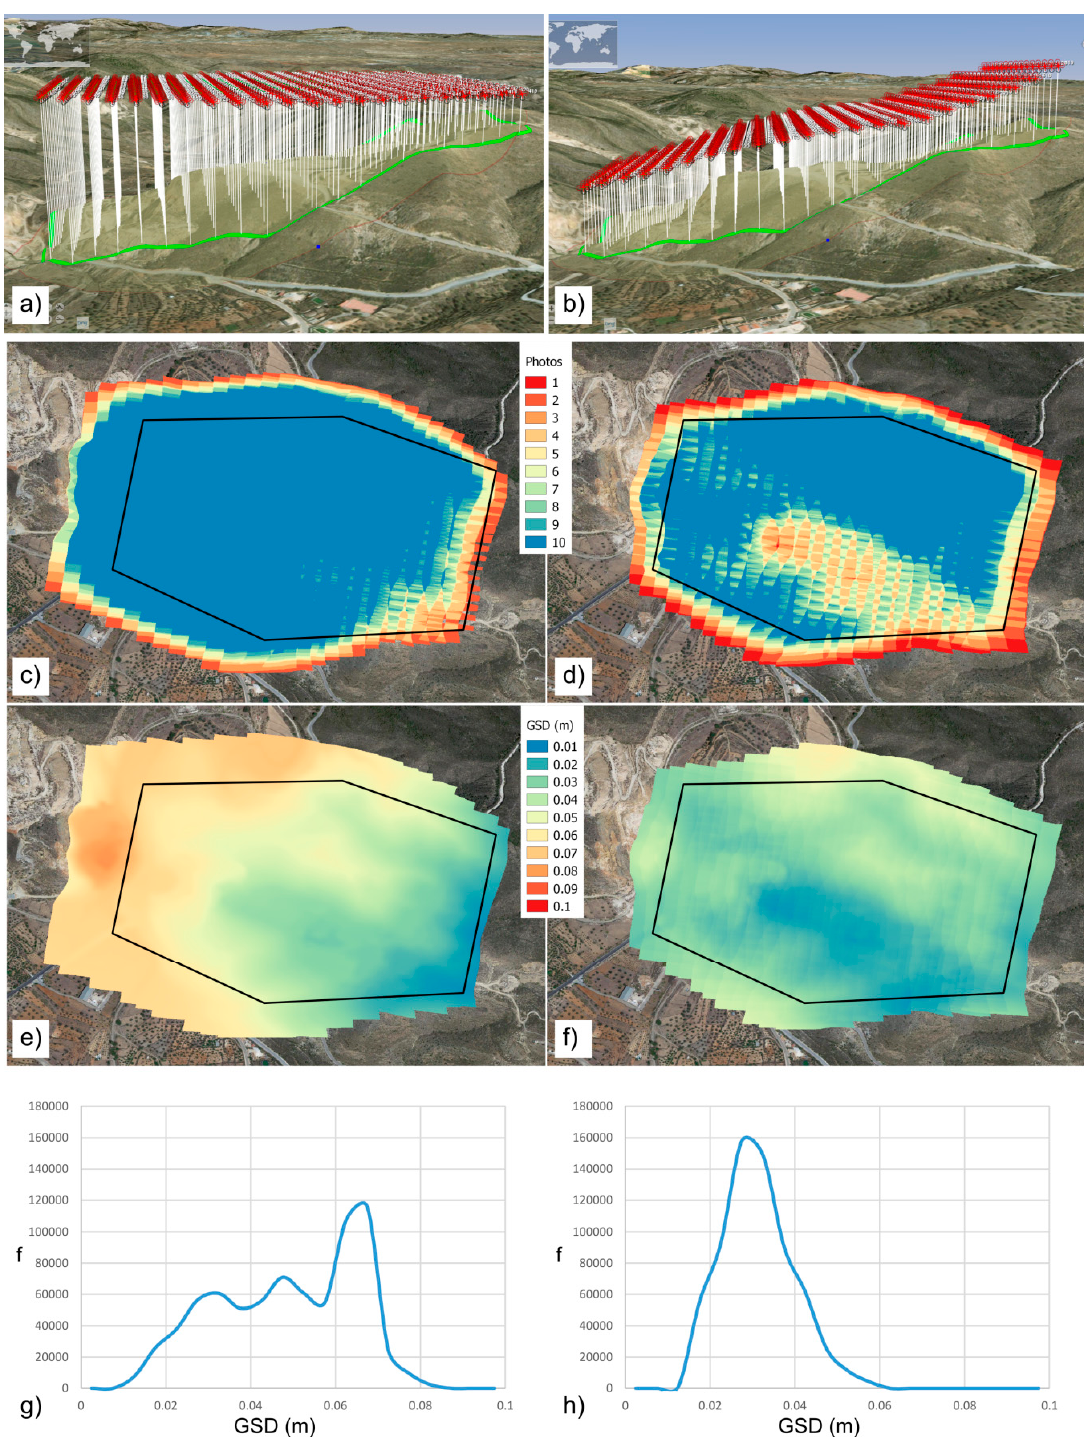
Figure 9. Influence of terrain morphology on block flight planning: ( a ) image locations using no-DEM option (flight height constant over terrain), ( b ) image locations using DEM option (variable flight height in strips considering terrain height), ( c ) and ( d ) number of recorded images (coverage map) for both projects, ( e ) and ( f ) GSD values for both projects, ( g ) and ( h ) frequency (number of cases) of GSD variation for both projects.